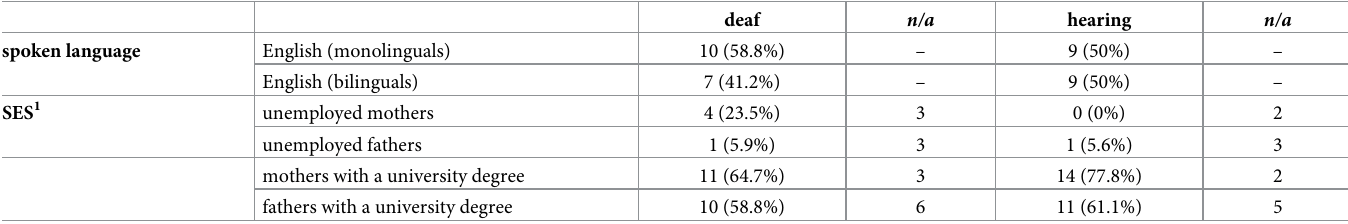
Table 1. Participants’ linguistic background and parental socioeconomic